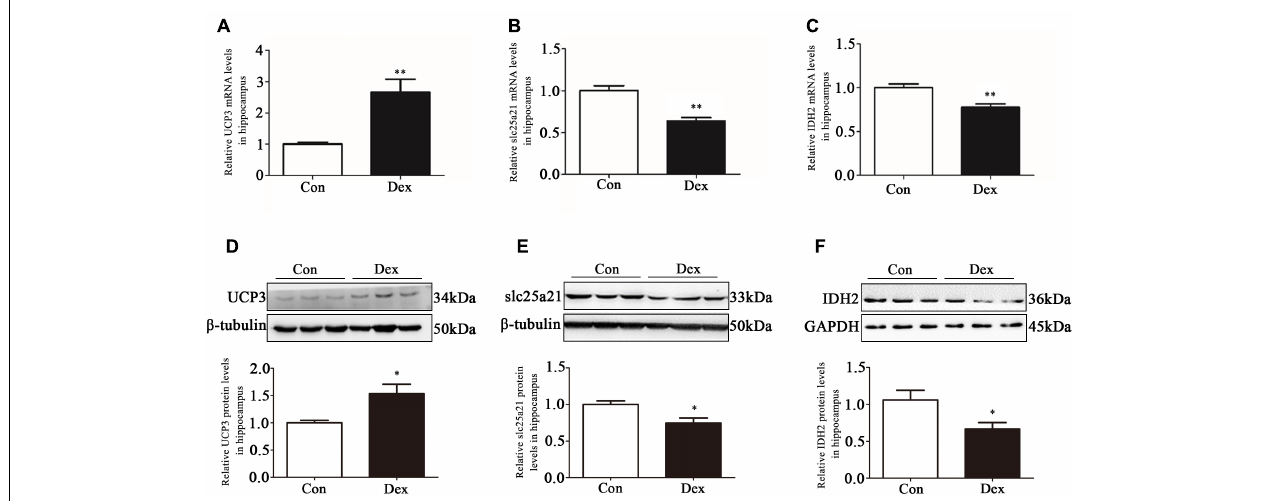
FIGURE 2 | Effects of prenatal Dex exposure on hippocampal UCP3, Slc25a21 and IDH2 expression in adult offspring. Pregnant rats at GD 14 to 21 were subcutaneously administered either 0.1 mg/kg/d Dex or vehicle (0.9% saline) once a day for 7 days. Hippocampal tissues were obtained from adult offspring rats (9-week old). UCP3 (A) , Slc25a21 (B) , and IDH2 (C) mRNA level was determined by Q-PCR. Protein level of UCP3 (D) , Slc25a21 (E) , and IDH2 (F) was determined by western blot analysis. Representative protein bands are presented above corresponding histogram. Data are presented as means ± SEM ( n = 10/group).